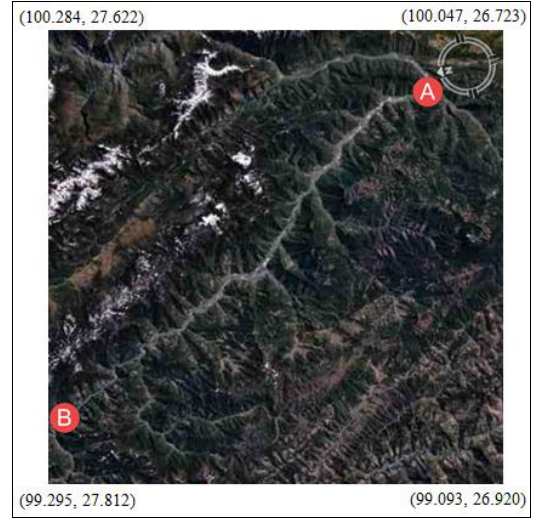
Figure 12. Cartographic Map-1.